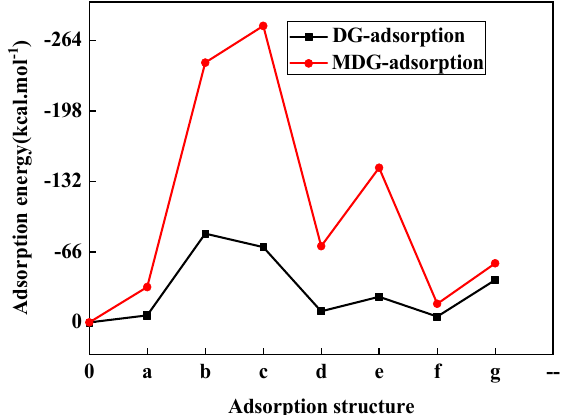
Figure 18. Adsorption energy of different adsorption configurations of MG molecules adsorbed by DG/MDG fiber ( − 1 1 0) surface.